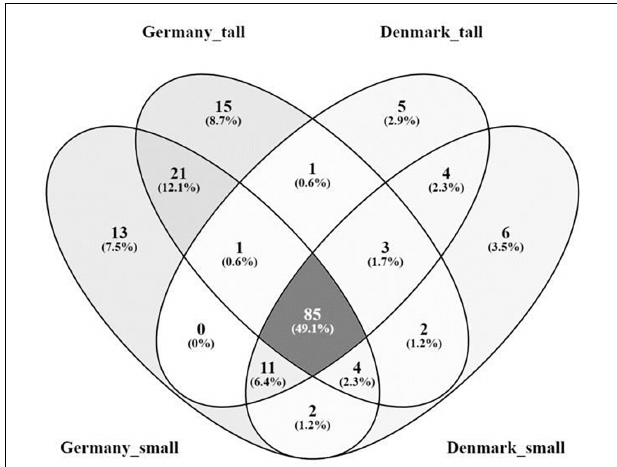
FIGURE 4 | Venn diagram of the rhizosphere core bacterial microbiome from tall and small plants of A. nordmanniana collected in Germany and Denmark. Analysis was carried out at the order level. Numbers represent the amount of shared and unique OTUs for each variable. The numbers in parentheses show the percentage of contribution of the core OTUs in relation to the total number of OTUs identified.